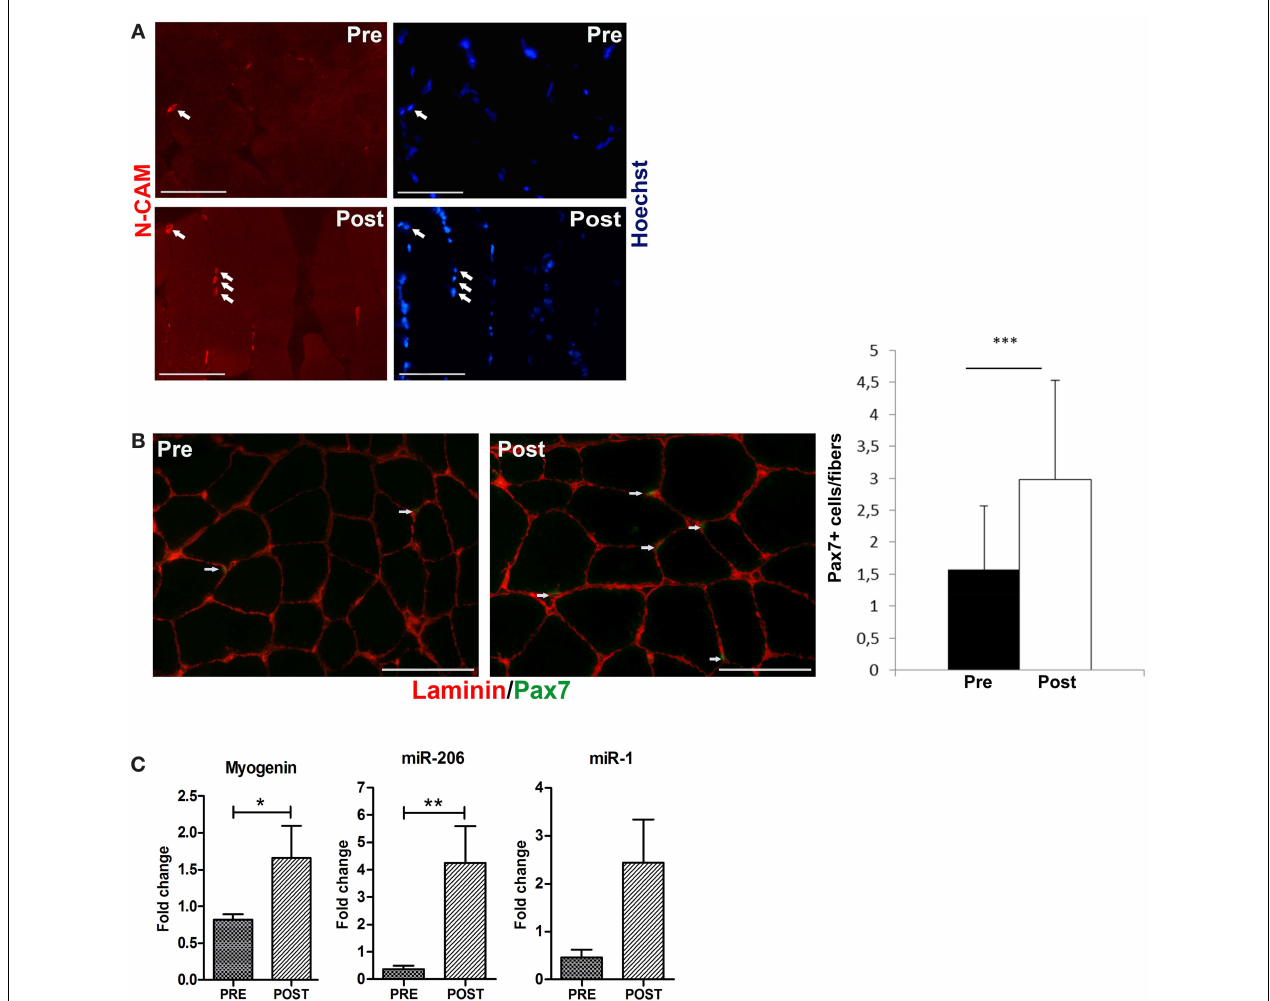
number of Pax7 positive cells (arrowed) is increased in biopsies of post-trained subjects, compared to the pre-training ones. Bar 100 µ m. Right panel: percentage of Pax7 + cells in pre-trained and post-ES-trained muscles. Data are represented as average ± SD. *** p < 0.0001. (C) Real time PCR analysis for myogenin, miR-206, and miR-1 expression in pre-trained (PRE) and post-ES-trained (POST) muscles. Data are represented as average ± SEM. n = 16. * p < 0.05; ** p <